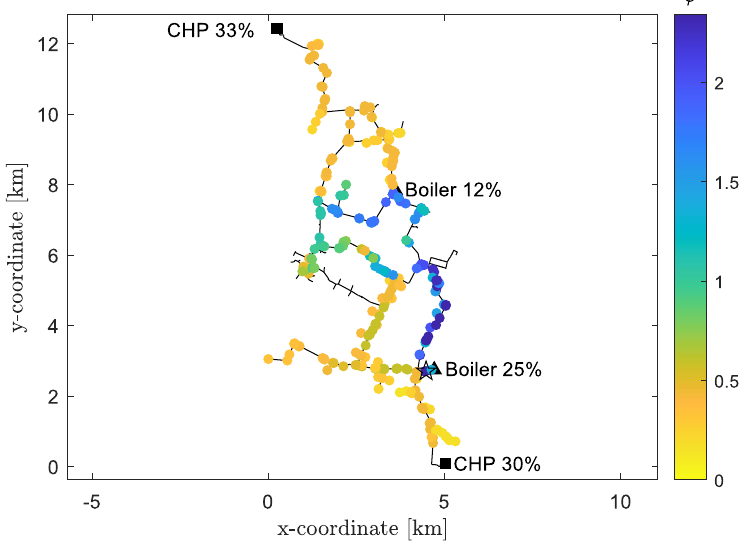
Figure 7. φ coefficient throughout the analyzed DH network when supplied by both cogeneration plants and heat-only boilers (the star indicates the best position) − Configuration 2, base case.